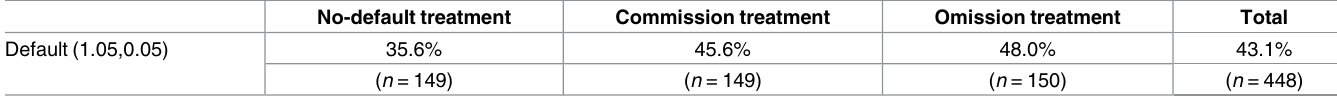
Note : In each cell we show the share of participants choosing the selfish allocation (1.05,0.05). In parentheses we show the total number of participants in each cell.